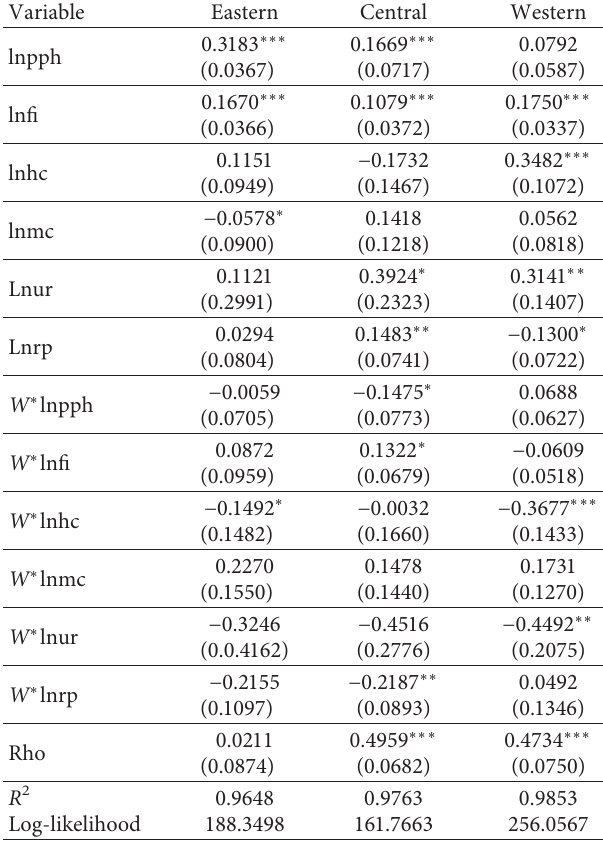
Table 9: SDM estimation results at the subnational